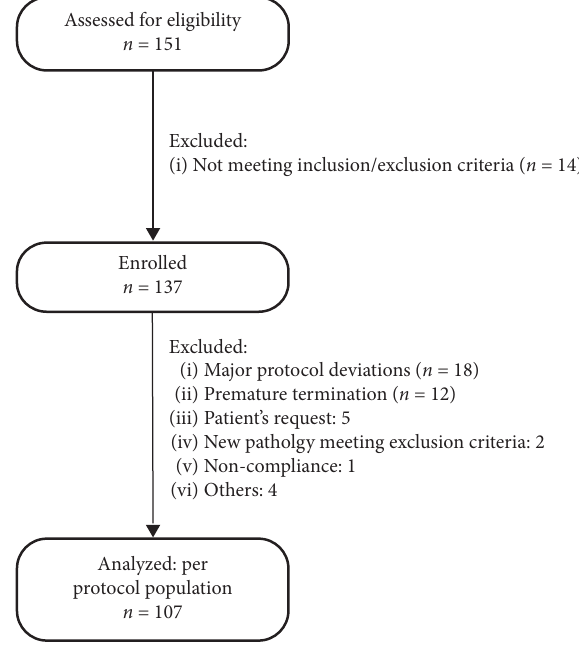
Figure 1: Study flowchart.